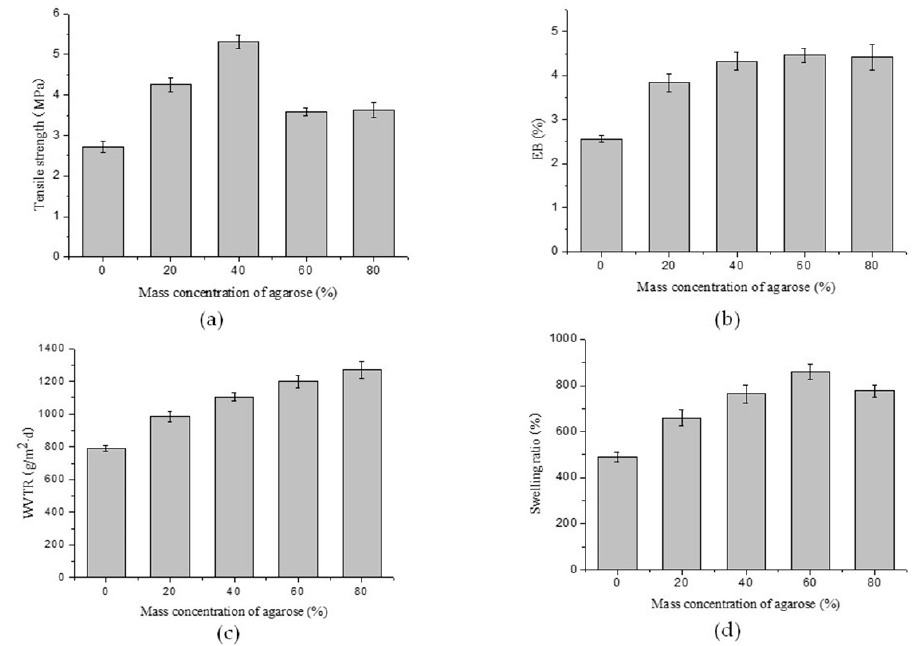
Figure 2. Effects of agarose mass ratios on ( a ) tensile strength; ( b ) elongation-at-break; ( c ) water vapor transmission rate; and ( d ) swelling ratios of the composite films.